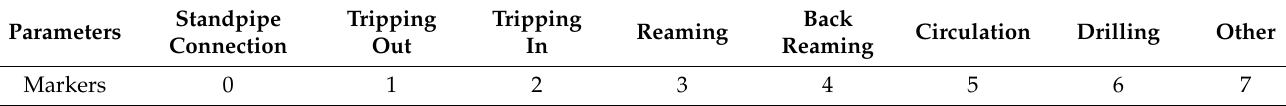
Table 3. Working condition marking method.